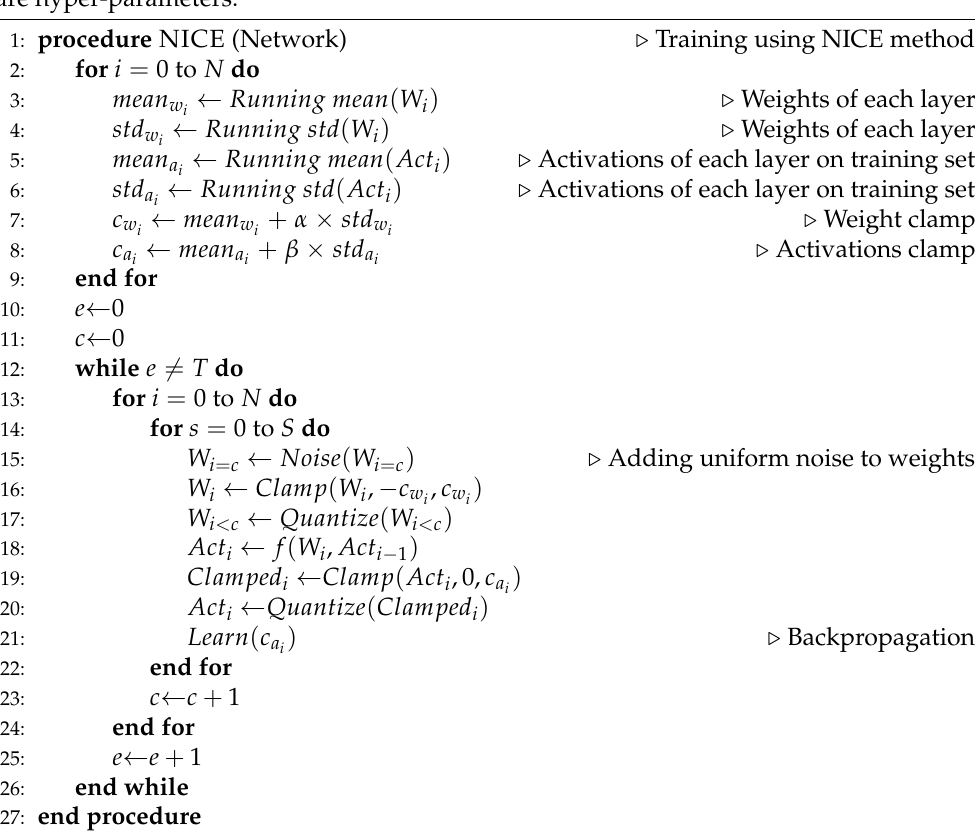
Algorithm 1 Training a neural network with NICE. N denotes the number of layers; S is the number of epochs in which each layer’s weights are noised; T is the total number of training epochs; c is the current noised layer; i denotes the i th layer; W is the weights of the layer; f denotes the layer’s function, i.e, convolution or fully connected; and α and β are